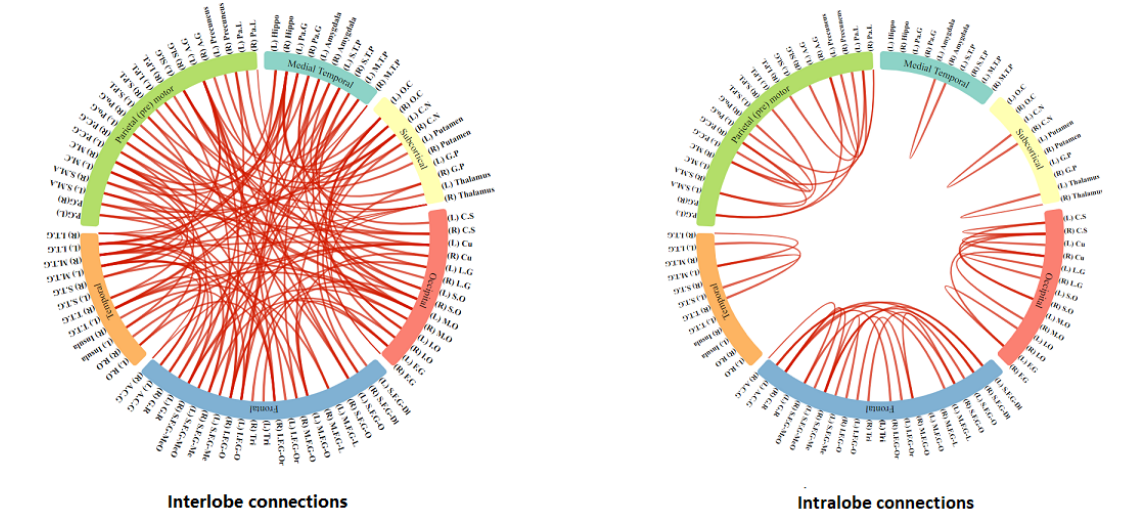
Figure 3. Brain’s lobes connectogram at the interlobe and intralobe level.